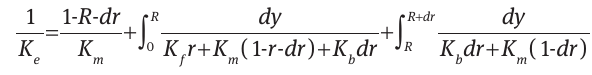
Table 2 Fibre volume fractions ( V Fibre radius